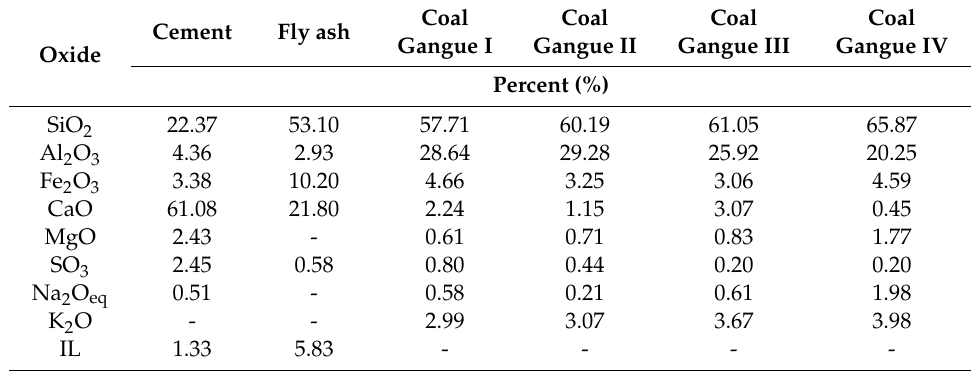
Table 1. Chemical compositions of cement, fly ash, and coal gangues.